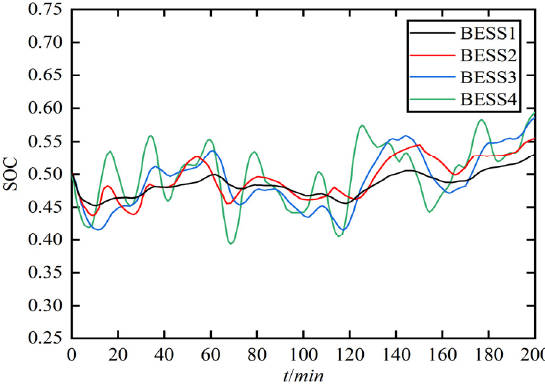
Figure 16. Output increment of conventional generator.